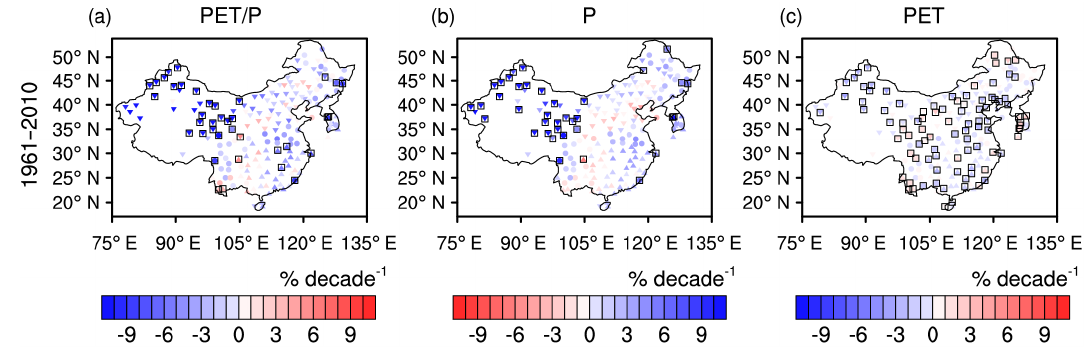
Figure 3. Spatial distributions of the trends in PET /P , P , and PET over continental eastern Asia. Panels (a–c) : the spatial distribution of trends in the annual mean PET /P (a) , P (b) , and PET (c) for the period of 1961–2010. Inverse triangles, circles, and triangles represent stations classified as arid, transitional, and humid regions, respectively. The open squares indicate that the trend is significant at the 95% confidence level.